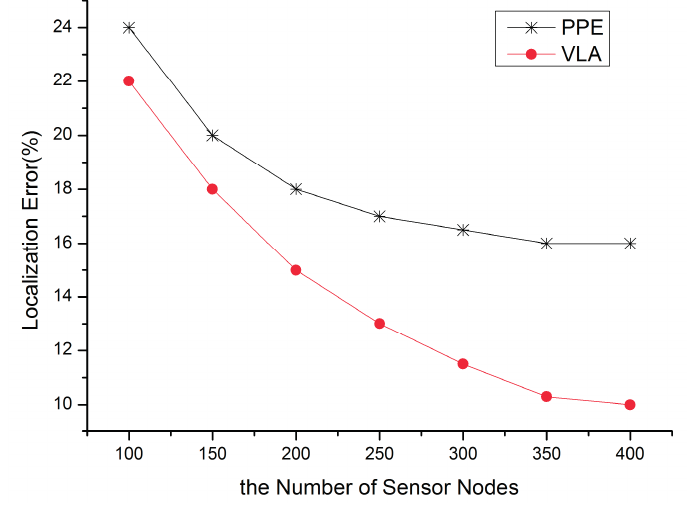
Figure 7. Node density vs. localzation